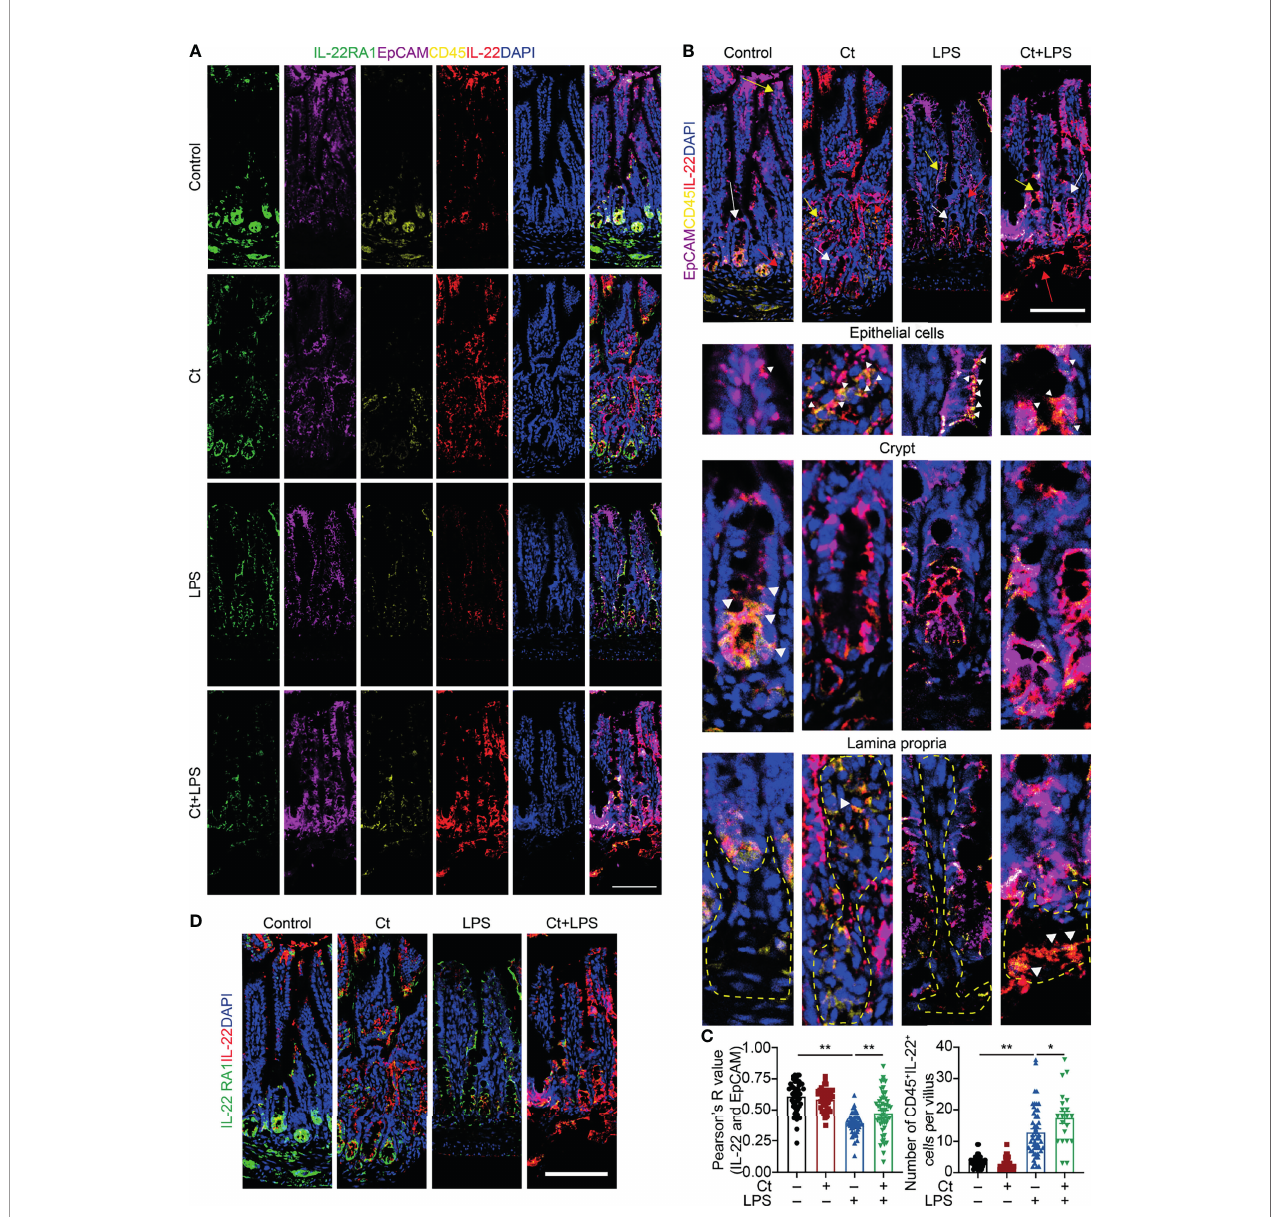
FIGURE 6 | Ct triggers immune cells to enhance the production of IL-22 in the ileal lamina propria. Ileal slices were stained with IL-22 (red), IL-22RA1 (green), EpCAM (violet), CD45 (yellow), and DAPI (blue). (A) In situ hybridization of IL-22, IL-22RA1, EpCAM, and CD45. (B) Colocalization of EpCAM, CD45, and IL-22 in the epithelial position, crypt, and lamina propria, respectively. White triangle: localization, yellow arrow: epithelial cells, white arrow: crypt, red arrow: lamina propria. (C) Analysis of IL-22 + EpCAM + and CD45 + IL-22 + cells. (D) Colocalization of IL-22 and IL-22RA1. Scale bar: 100 m m. Data were presented as mean ± SEM. The signi fi cant difference was analyzed by two-way unpaired t-tests. * P < 0.05, ** P <